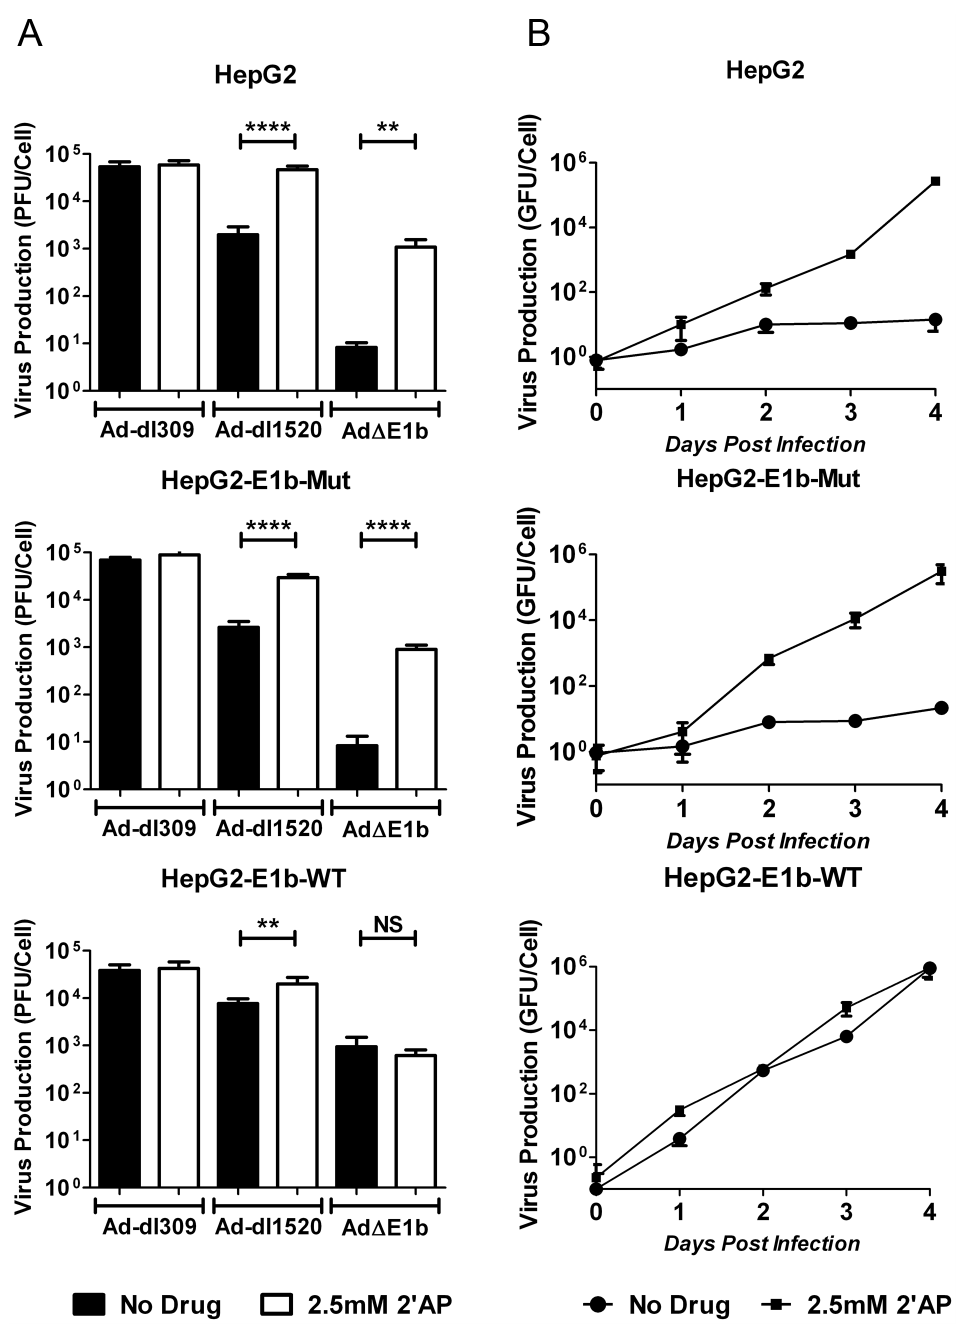
Figure 8. 2 9 AP rescued the C454S/C456S E1b-55K mutation in HepG2 cells. (A) Parental HepG2, HepG2-E1b-WT and HepG2-E1b-Mut were infected with Ad-dl309, Ad-dl1520 or Ad D E1b at MOI of 1 PFU/cell for 1 hour prior to treatment with medium containing no drug or 2.5 mM 2 9 AP. Infected cells and media were harvested 4 days post-infection and virus yields were determine by plaque assays on HEK293 cells. (B) Cells were infected with Ad D E1b at MOI of 1 GFU/cell for 1 hour prior to treatment with medium containing no drug or 2.5 mM 2 9 AP. Lysates from infected cells were harvested at 1 hr (day 0) as well as 1, 2, 3 and 4 days post-infection. Virus yields were determined by titration in Hep3B cells as described in the materials and methods. Error bars correspond to + / 2 SD of quadruplicates (NS – Not Significant; ****p , 0.0001, **p , 0.01, one-way ANOVA). doi:10.1371/journal.pone.0065222.g008 (e.g., Figure 9C). An activity of E1b-55K that is dependent on Mut and parental HepG2 cells were infected with the replicating cysteine residues at 454 and/or 456 appeared to be critical for viruses and incubated 6 days with or without 2.5 mM 2 9 AP prior virus-mediated cell death, as the E1b-55K mutant protein did not to survival assessment (Figure 9). In the absence of 2 9 AP, efficient complement the E1b-deleted viruses (Figure 9B). Furthermore, killing by virus at an MOI of 100 VP/cell (about 1 infectious unit/ similar to its effect on virus production (Figure 6), 2 9 AP treatment cell) required an intact E1b-55K protein either encoded by the could substitute for E1b-55K in killing by Ad D E1b and virus (e.g., Ad-dl309 in Figure 9A) or provided in trans by the cells